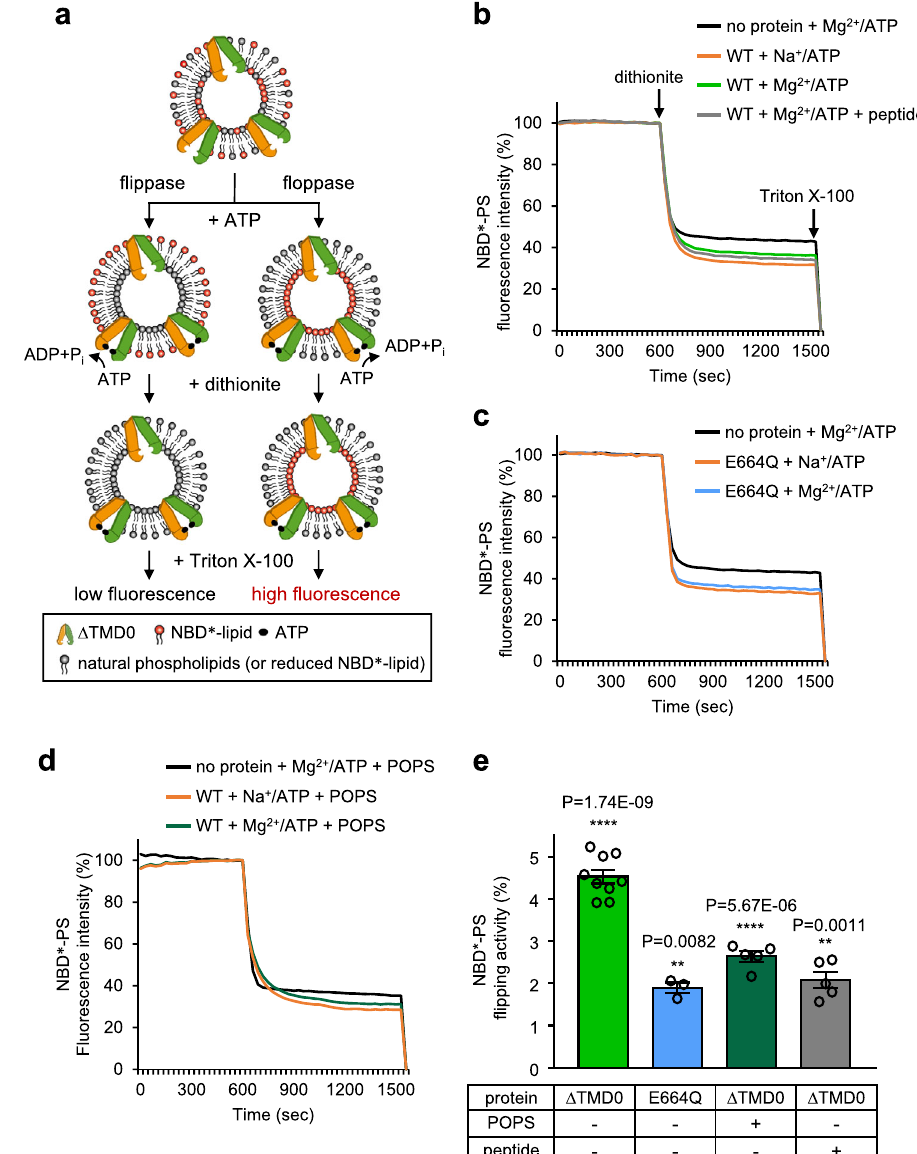
Fig. 2 | ATP-dependent NBD*-PS transport activity. a Schematic of the fl uorescence-based fl ip – fl op assay used in this study. b Fluorescence traces